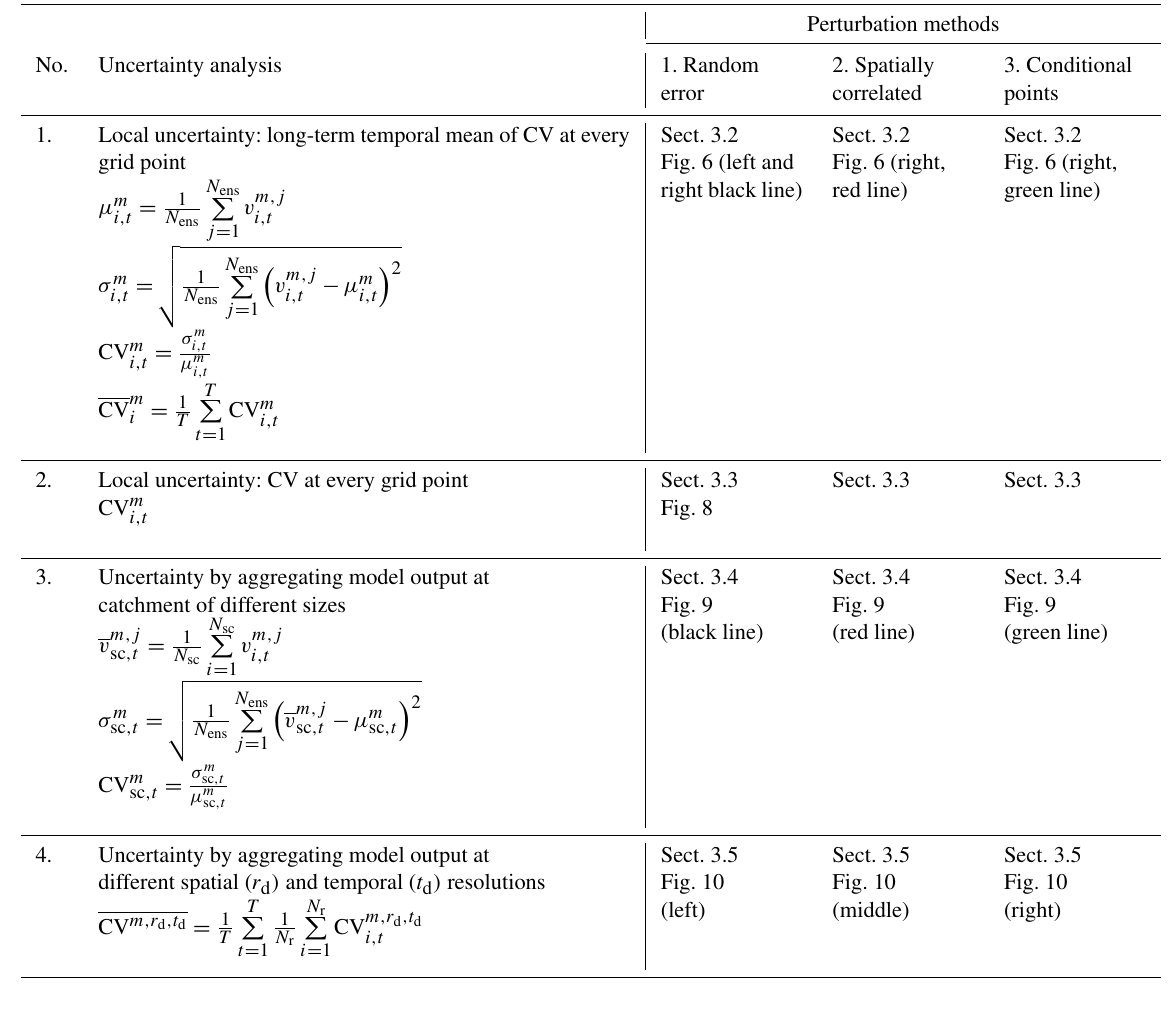
Table 2. Overview of the uncertainty analysis presented and